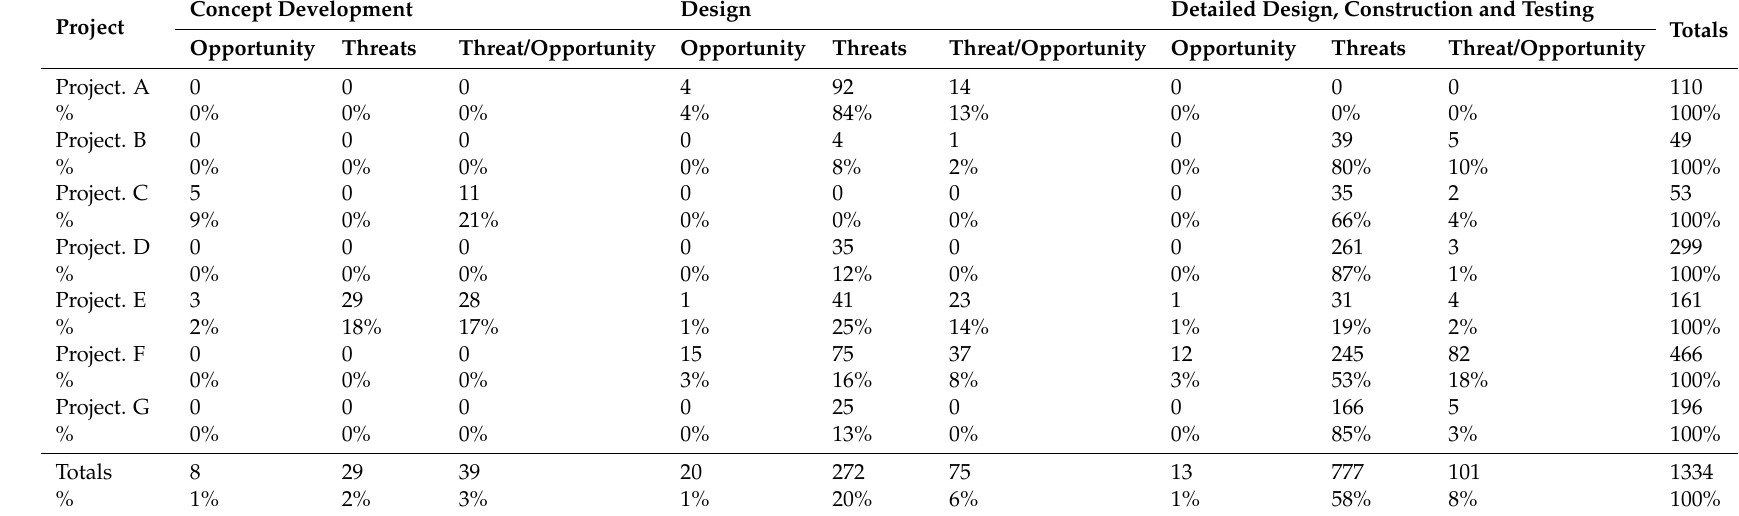
Table 1. Distribution of identified uncertainties: Threat/opportunity categories in the energy sector